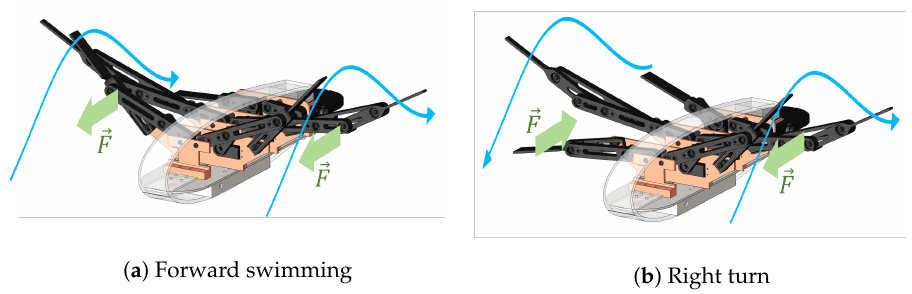
Figure 14. Travelling waves directions and propulsive forces generated by the fin